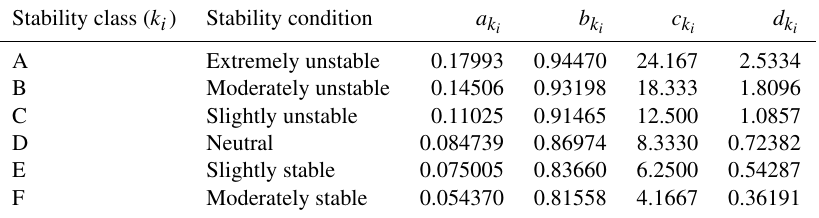
) and vertical (σ z ) standard deviations of the plume when x i is in metres i ,k i i ,k i